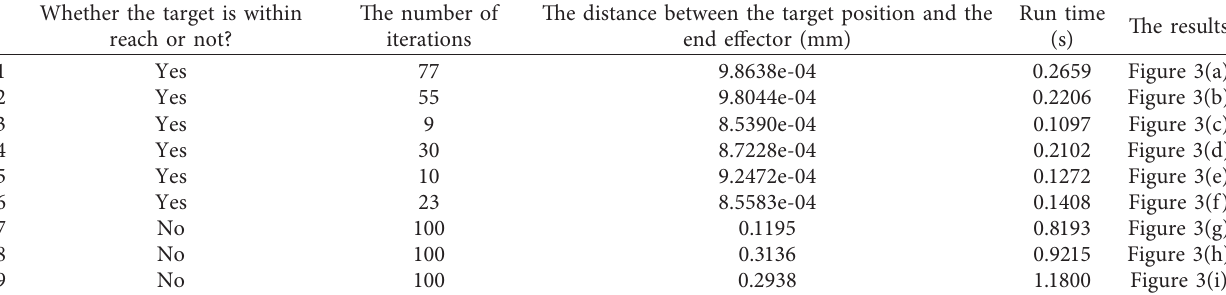
Table 1: The experiment results of extending FABRIK with obstacle avoidance in test 1.